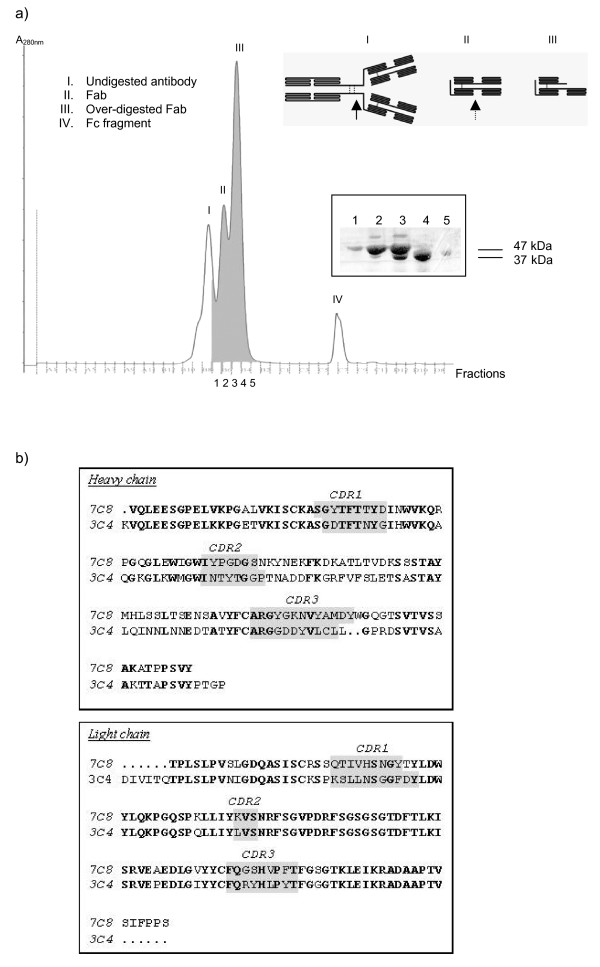
Fab production, purification and sequencing. A. Chromatogram of separation of papain digestion products using Superdex-75. The undigested mAb (I) is eluted first, followed by the Fab fragments (II & III) and the Fc fragments along with other small digestion products (IV) are collected last. Bottom right: Analysis of fractions 1–5 on 10% SDS gel demonstrate separation of the Fab fragments (47 kDa) from the over-digested Fab fragments (≈ 37 kDa). Top right: Schematic diagram of mAb digestion by papain as previously described in literature [18]. The bold arrow indicates were papain digests primarily before the cysteine-bridges on mAb (I). The papain can also digest the Fab fragment produced (II), as indicated by dashed arrow. The digested Fab (III) may be missing one of the Fv regions. B. The variable regions of 7C8 and 3C4 heavy and light chains, are aligned respectively. The CDR regions as indicated by immunoglobulin superfamily database [31] are shaded.